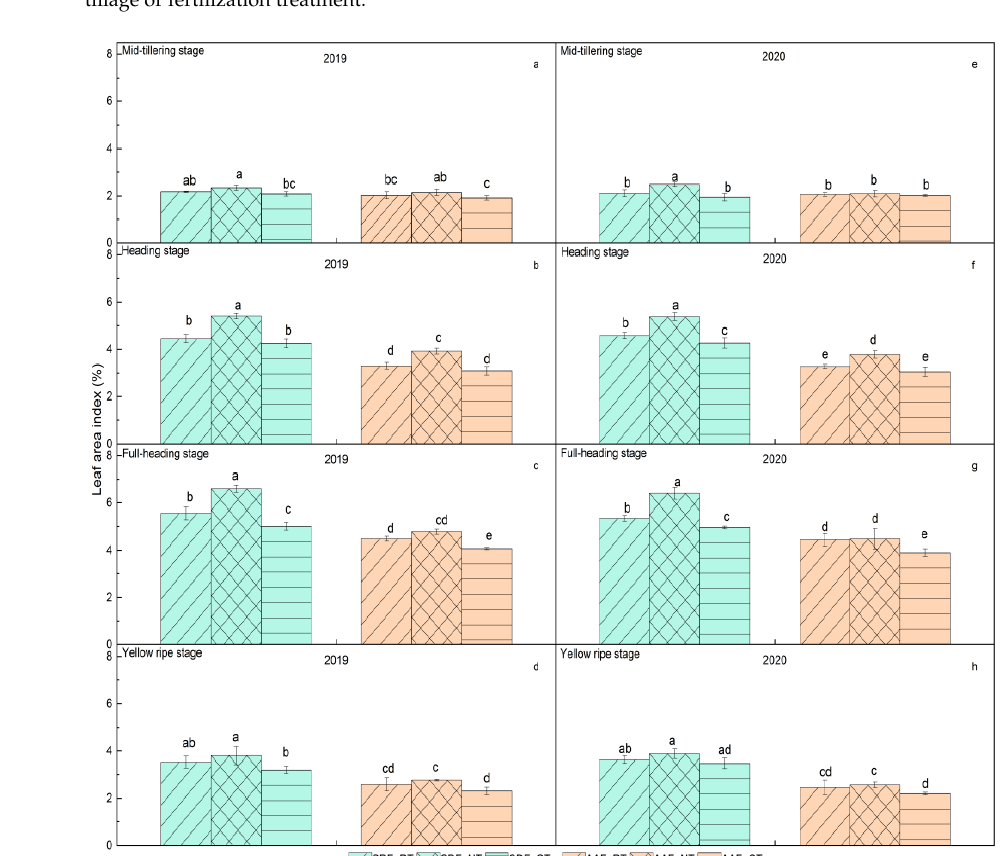
Figure 3. Leaf area index (LAI) at different stages of rice under different tillage and fertilization treatments. ( a – d ) represent the leaf area index in mid-tillering stage, heading stage, full-heading stage, and yellow ripe stage in 2019, respectively. ( e – h ) represent the leaf area index in mid-tillering stage, heading stage, full-heading stage, and yellow ripe stage in 2020, respectively. Different lowercase letters marked on the histogram mean significant differences among treatments at the 5% level according to Duncan’s multiple-range test (0.05) (similarly hereinafter).